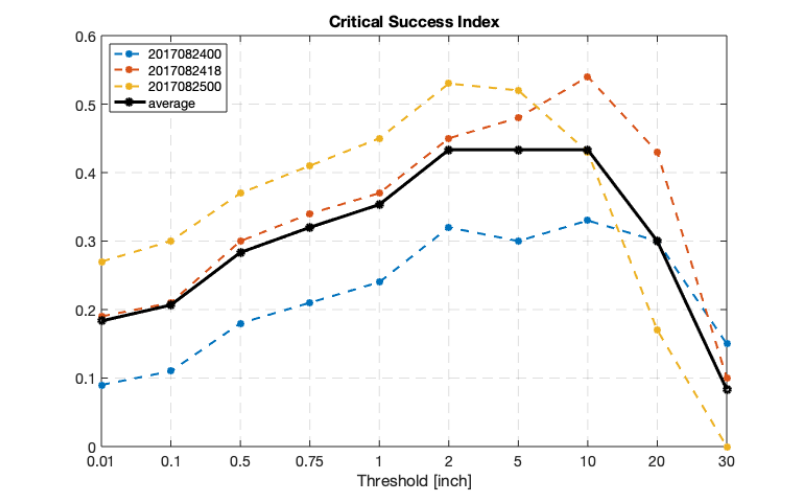
Figure 5. Colored lines are the critical success index (CSI) corresponding to three selected cycles: blue is 0000 UTC 24 August 2017, red is 1800 UTC 24 August 2017, and yellow is 0000 UTC 25 August 2017. The black line is the averaged CSI. The x-axis shows the accumulated rainfall